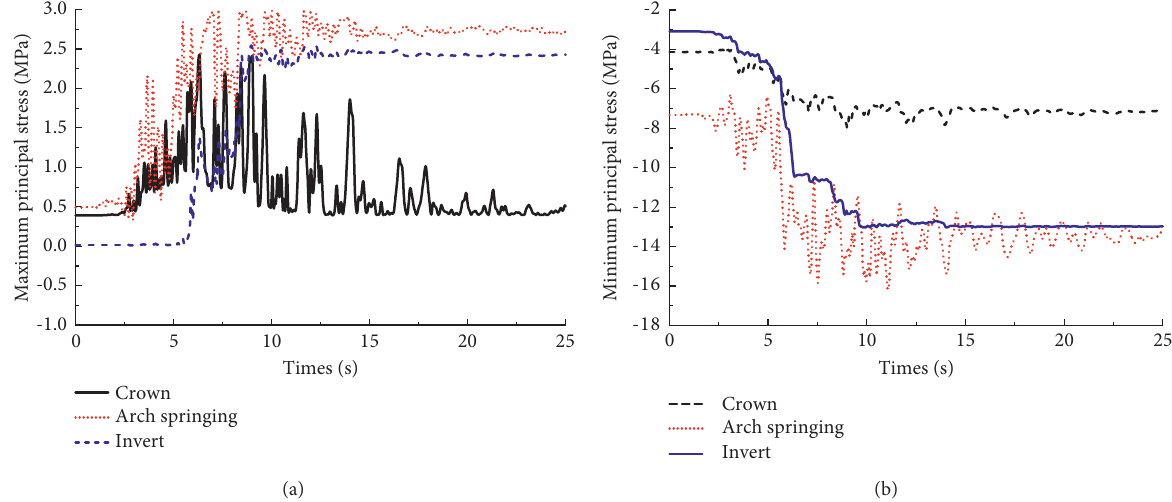
Figure 8: Principal stress-time history curve of typical parts of the lining. (a) Maximum principal stress. (b) Minimum principal stress.